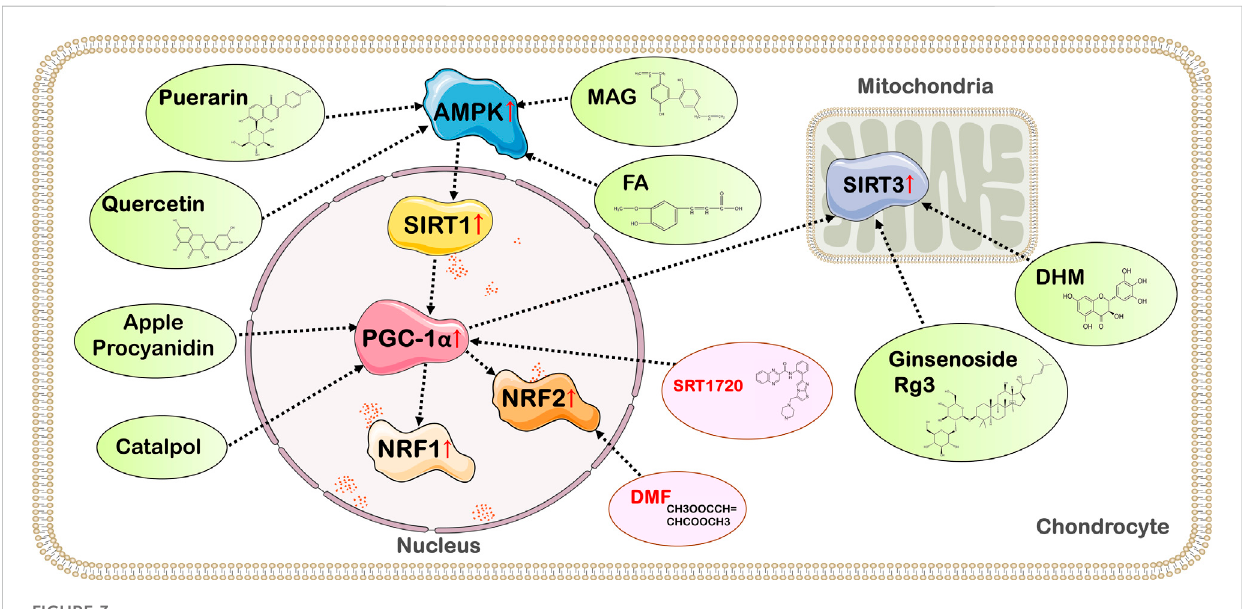
FIGURE 3 Targets of action of drugs with therapeutic effects on OA by affecting the activity of PGC-1 α . Quercetin, FA, MAG, geraniin, and Br in RB@MPMW promotePGC-1 α expressionanddelaythedeterioration ofOAbyactivatingtheAMPK/SIRT1/PGC-1 α signalingpathway;AppleProcyanidinsandcatalpol can affect PGC-1 α activity and ameliorate mitochondrial damage in OA chondrocytes; Ginsenoside Rg3 and DHM exert anti-in fl ammatory and chondrocyte homeostatic effects through the PGC-1 α /SIRT3 pathway; SRT1720, an activator of SIRT1, exerts chondroprotective effects by